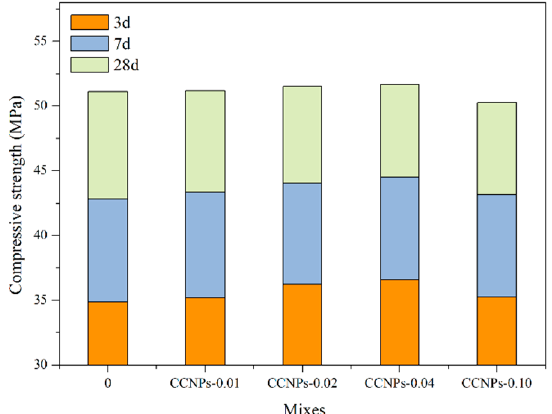
Figure 9. Compressive strength of cement mortar with different amounts of CCNPs.